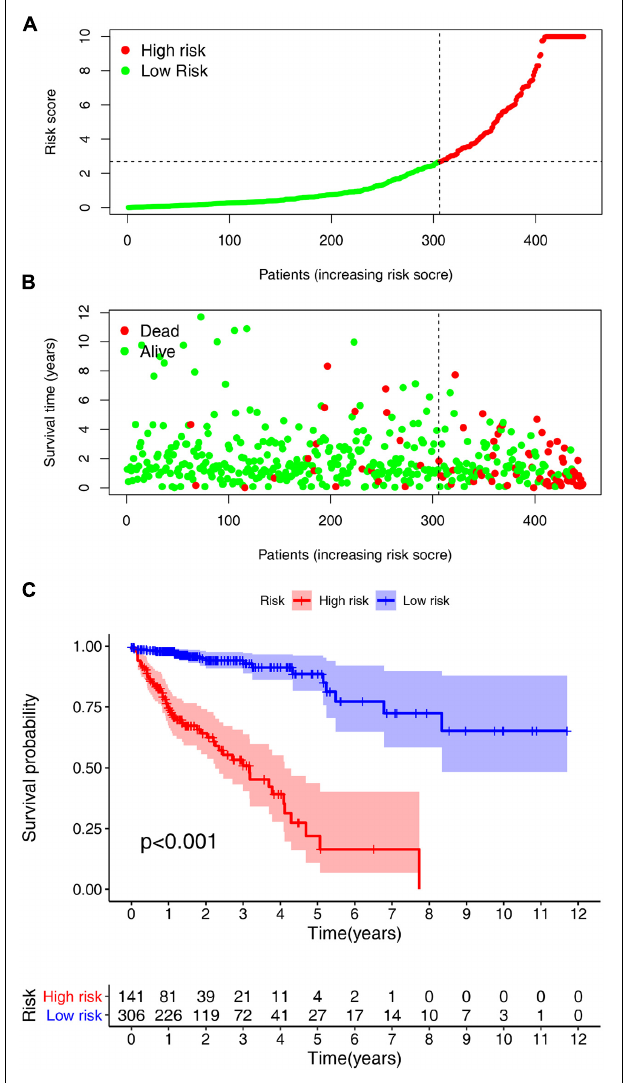
FIGURE 5 | Risk score analyses and survival analyses of the constructed model in Colorectal cancer (CRC). Risk scores and survival outcome of the constructed model in CRC was plotted based on 447 patients. (A) Vertical coordinate represents risk scores and horizontal coordinate is the patient data. The low-risk curve was in green and the high- risk curve in red. The risk scores were increasing. (B) Green dots, referring to people still alive, were localized in the low-risk area; and red dots, referring to people who were already dead, were localized in the high-risk area. As the risk scores mounted, the number of deaths increased. (C) The survival curve indicated that the patients in the high-risk group experienced a poorer prognosis than those in the low-risk